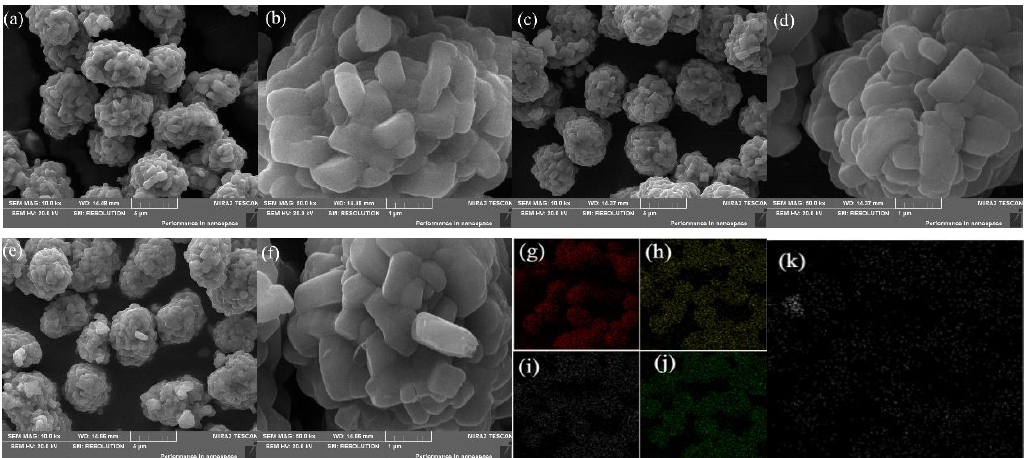
Figure 2. SEM images of MS1 ( a and b ) , MS3 ( c and d ), MS5 ( e and f ), and the corresponding EDS mappings of image MS3 ( c ): ( g )-O, ( h )-Ni, ( i )-Co, ( j )-Mn, ( k )-Sn.